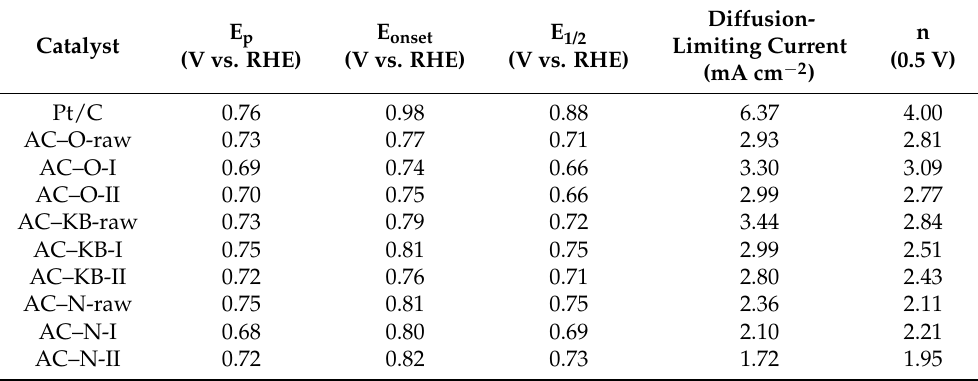
Table 5. ORR performance parameters of the obtained N-doped activated carbons and commercial Pt/C catalysts tested in alkaline